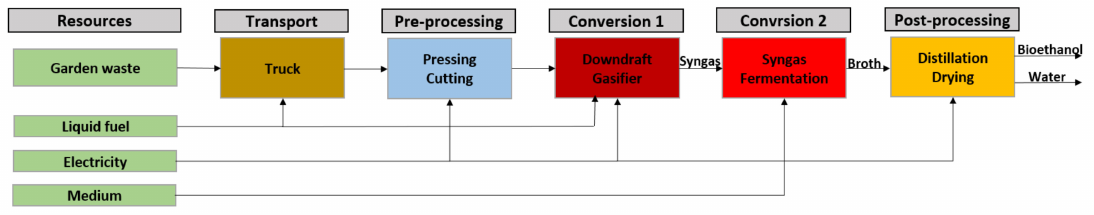
Figure 1. System boundaries, considered technologies, and associated